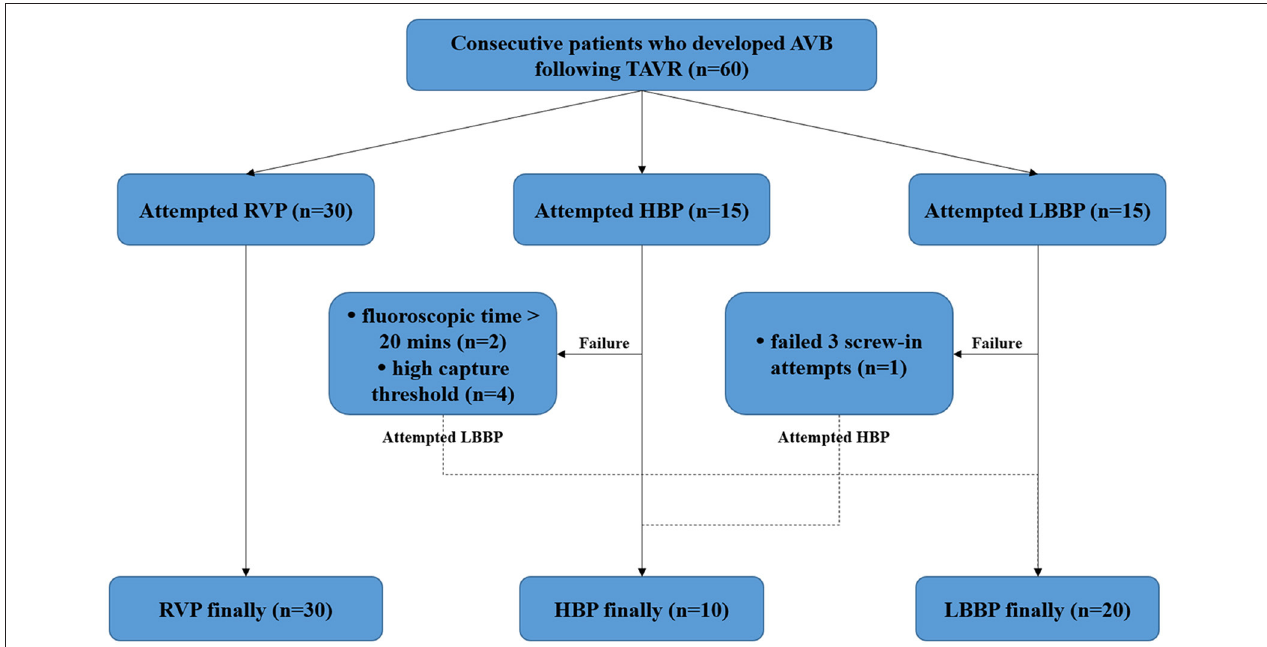
FIGURE 1 | Study flow diagram. AVB, atrioventricular block; HBP, His bundle pacing; LBBP, left bundle branch pacing; RVP, right ventricular pacing; TAVR, transcatheter aortic valve